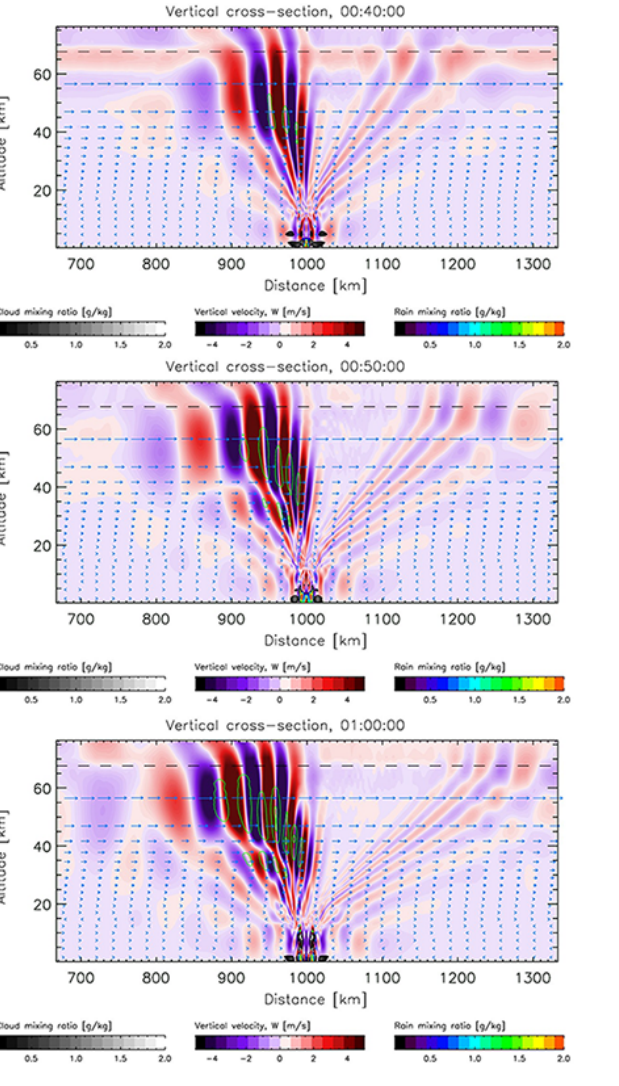
Figure 1. Vertical cross section of wind vertical velocity, w (ms − 1 ), cloud water mixing ratio (gkg − 1 ) and rain water mixing ratio (gkg − 1 ) at t = 40, 50, 60, 70, 80, and 90min (from top to bottom). Arrow’s length is proportional to the horizontal component of background wind velocity (1km on the x axis is equal to 4ms − 1 ). Green contour lines show absolute values of the ratio between potential temperature anomaly and its horizontally averaged